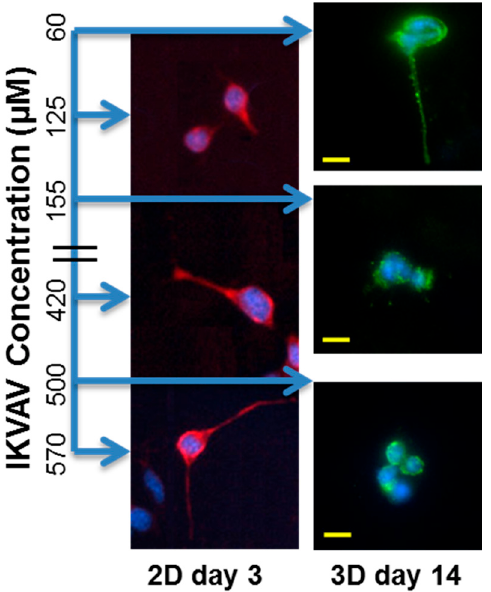
Figure 3. Beta III tubulin staining of neurite extension of cells in 2D (red) and 3D (green) culture with nuclear staining (blue) exposed to a continuous IKVAV gradient in polyethylene glycol hydrogels after 3 days of culture in 2D and 14 days of culture in 3D. Scale bars: 10 µ m. Adapted with permission from [73]. Copyright 2015 Elsevier.